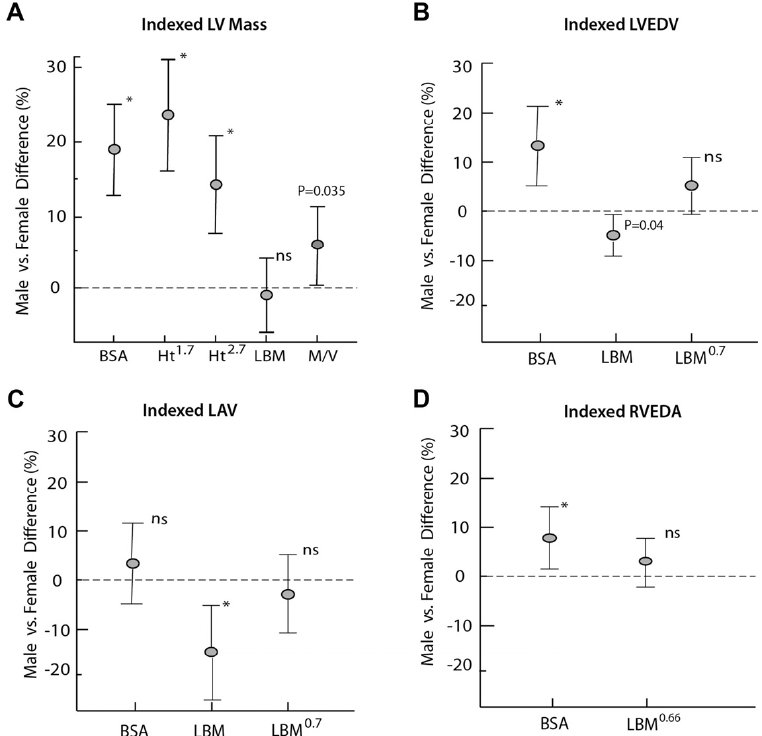
Figure 4. Reprinted with permission from ref. [62]. 2015 Elsevier Inc. Gender-associated relative difference in structural indexes using different scaling parameters. Allometric indexing to LBM significantly reduced differences between men and women. Data are presented for ( A ) LV mass, ( B ) LV end-diastolic volume, ( C ) left atrial volume, and ( D ) RV end-diastolic area. * significant difference between males and females ( p < 0.05); ns is not significant.